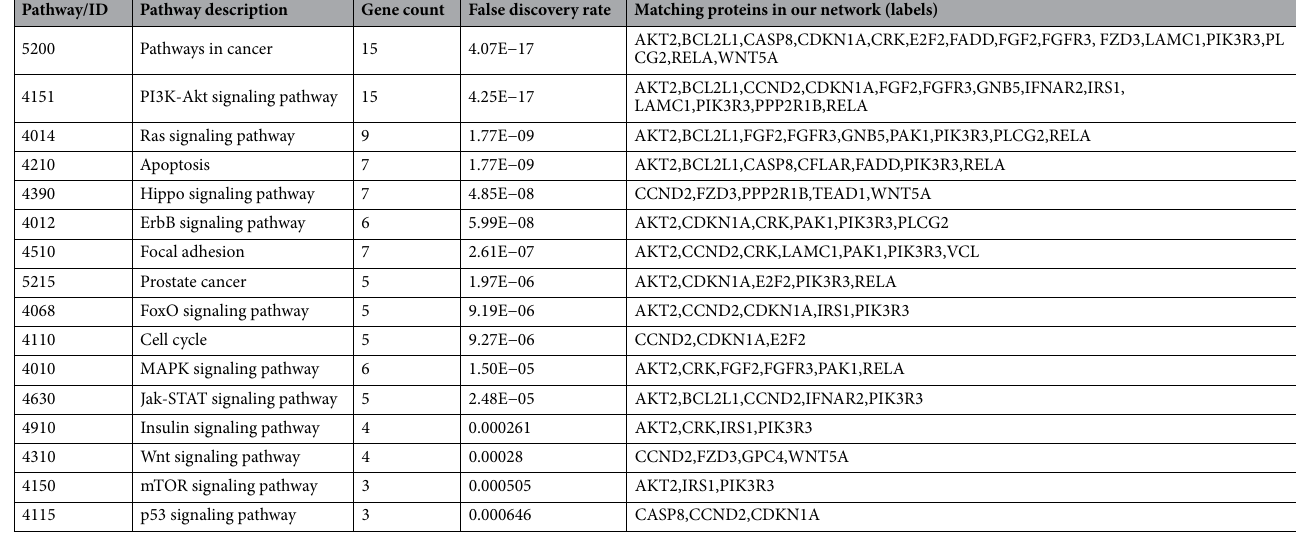
Table 4. KEGG pathways and matched member